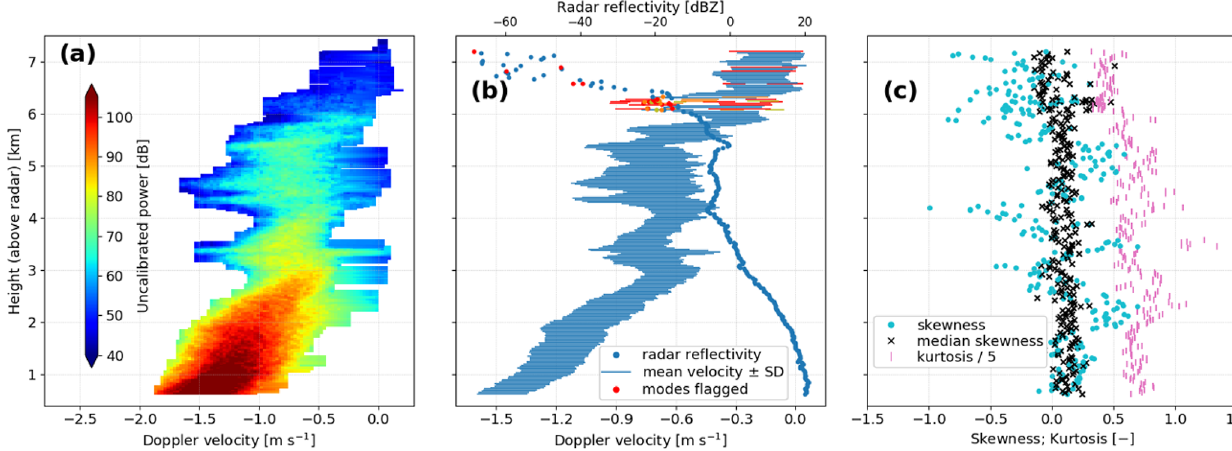
Figure 8. Summary of analysis results for a birdbath scan recorded at DWD’s Isen (ISN) radar near Munich during a snowfall event in December 2021 (data timestamp: 9 December 2021, 06:04:12UTC); (a) isolated weather signal analogous to Fig. 5a and (b) modal properties of lower-order and (c) higher-order Doppler moments corresponding to the test case at the MOHp radar shown in Fig. 6a and b,